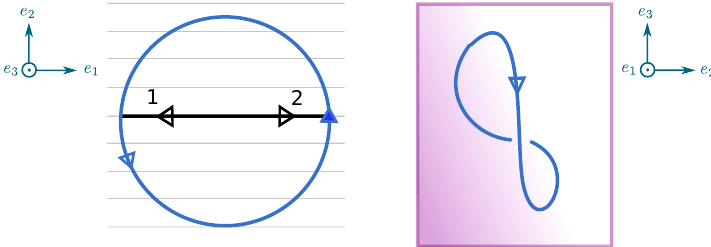
Figure 22 . An unknot K . Left: the projection of K to C . The height ( x 3 ) coordinate of K is taken as follows: as we travel counterclockwise around K the height monotonically increases, except for a small neighborhood of the (cid:12)lled arrow, where the height decreases. The projections of generic leaves of the WKB foliation are shown in light gray. The projection of the leaf segment along which an exchange may occur is shown in black. Right: the projection of K to the leaf space of the foliation. The position of the crossing in this projection corresponds to the location of the potential exchange.